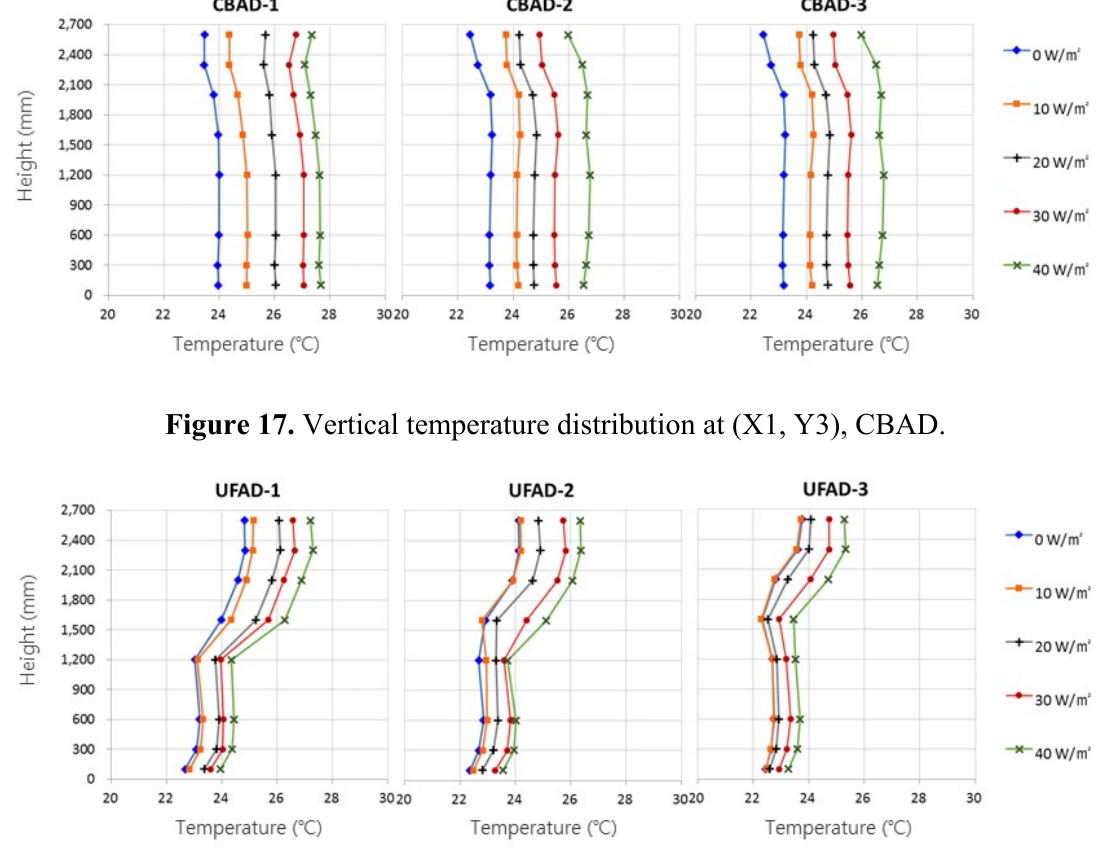
Figure 18. Vertical Temperature Distribution at (X1, Y3),